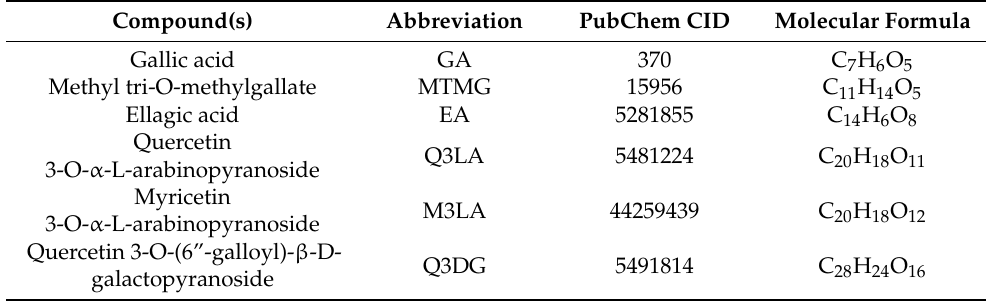
Table 2. Nomenclature, abbreviation, PubChem CID, and molecular formula of the selected isolated phenolic compounds from W. fruticosa leaves for in silico studies.